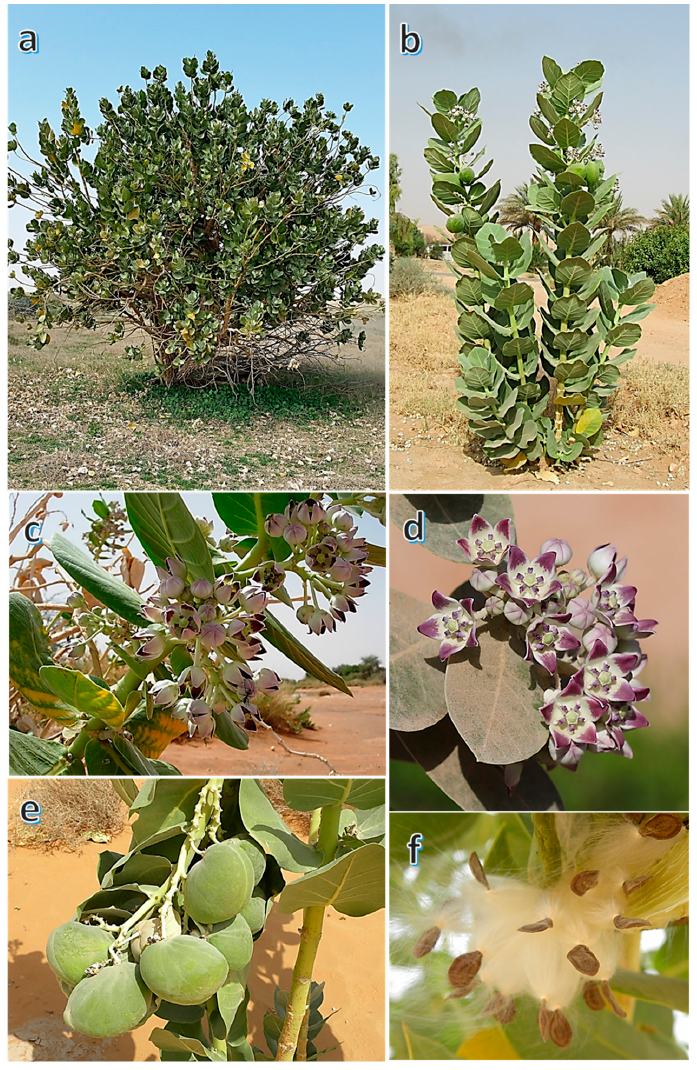
Figure 5. Calotropis procera (Aiton) W.T. Aiton ( a ) Overview of an old tree, ( b ) Overview of a young tree, ( c ) Close view of flowering branch, ( d ) flowers, ( e ) fruits, and ( f )